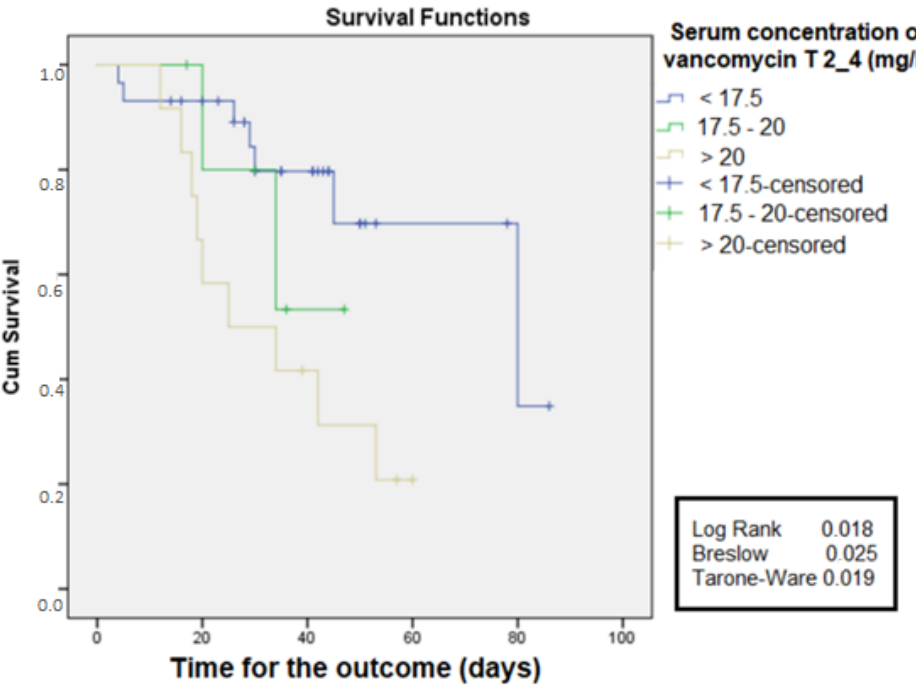
Figure 4. Free time for the outcome of death according to values of serum concentration between T2-4 days (48–96 h) of vancomycin use in ICU patients.